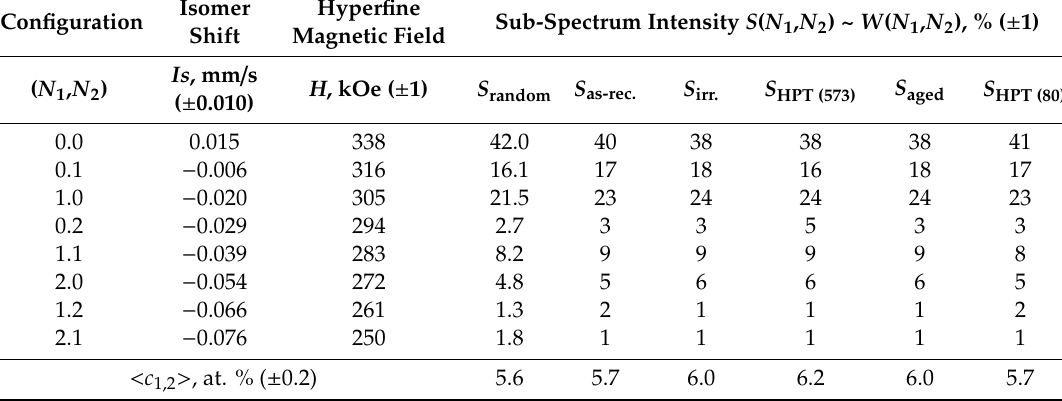
Table 1. Hyperfine Mössbauer parameters, intensities S ( N 1 , N 2 ) of subspectra and < c 1,2 > for the Fe 94 Cr 6 alloy in di ff erent states: S random –theoretical; S as-rec. –as received; S irr. –irradiated; S HPT (573) –HPT at 573 K; S aged –aged at 773 K, 50 h; S HPT (80) –aged and HPT at 80 K.